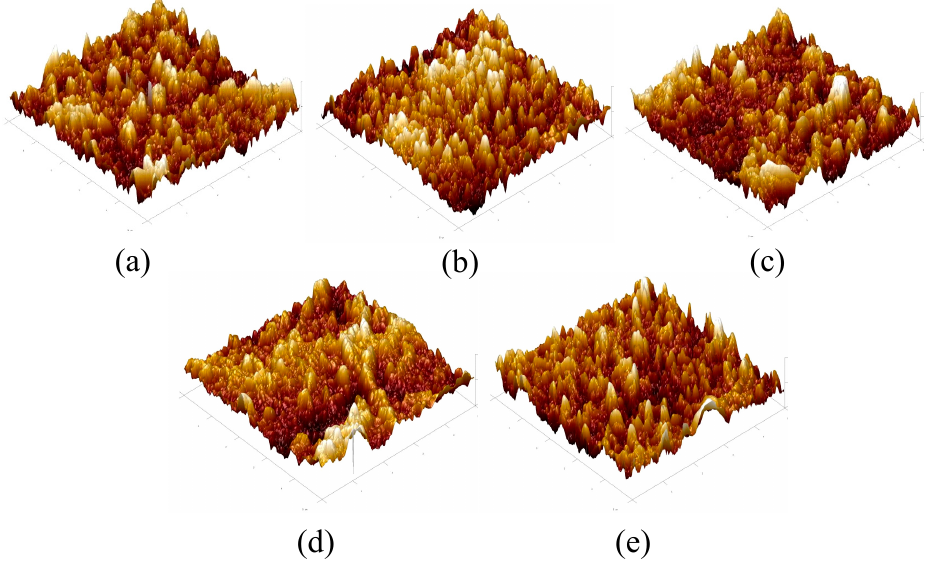
Figure 8. The AFM images of the TFC-FO membranes with different amounts of MXene nano-sheets: ( a ) T-1; ( b ) T-2; ( c ) T-3; ( d ) T-4, and ( e ) T-5. Table 1. The surface roughness of the TFC-FO membranes with different amounts of MXene nano-sheets. TFC-FO